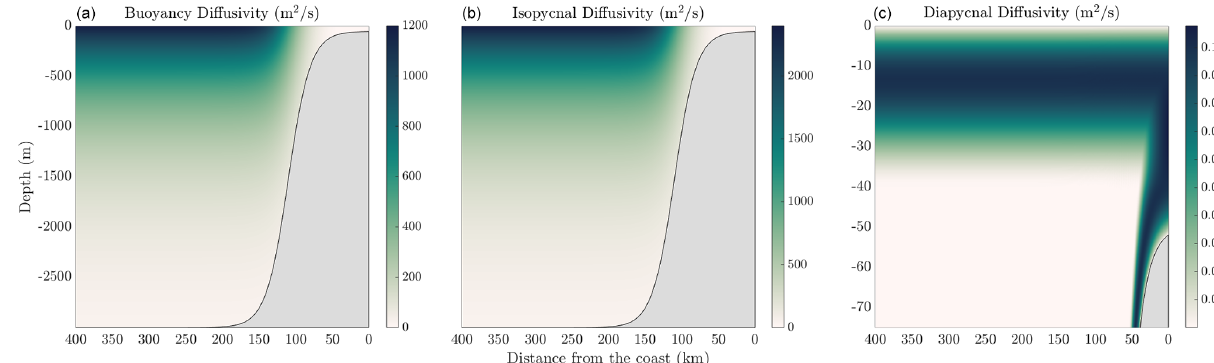
Figure 6. Inputs of buoyancy diffusivity (a) , isopycnal diffusivity (b) , and diapycnal diffusivity (c) used in the reference solution to MAME- BUS shown in Sect. 5. Note that the isopycnal and diapycnal diffusivities are shown over the entire domain, and the diapycnal diffusivities are shown over the upper 75m of the domain to highlight the boundary layer mixing and the mixing on the eastern side of the domain on the shelf where the boundary layers merge.